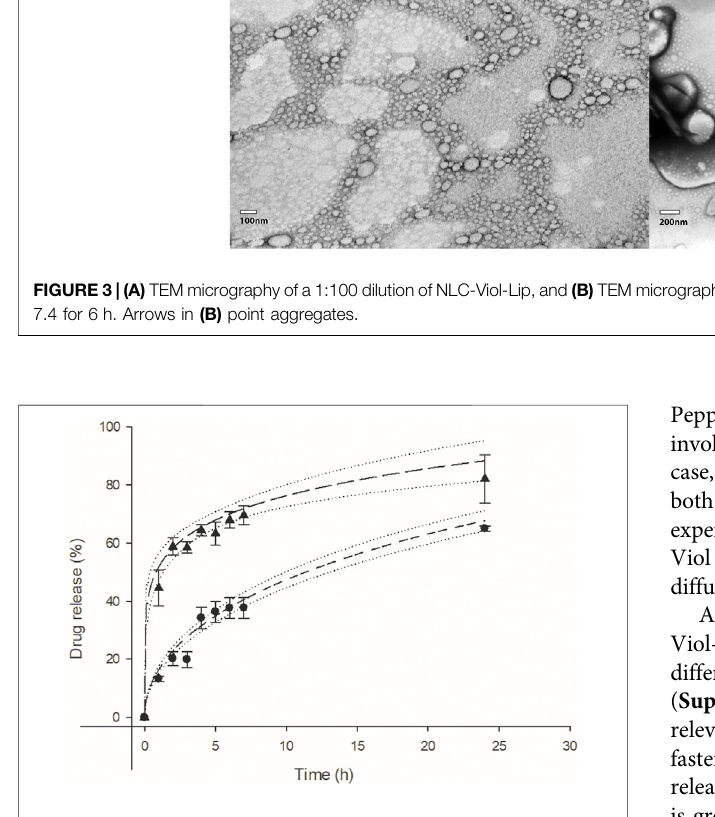
FIGURE 4 | Violacein kinetic release from mesh ( C ), and mesh containinglipase( ▲ )atpH=7.4respectively.BakerandLonsdalemodel fi tfor mesh ( − − , R 2 = 0.95) and Korsmeyer-Peppas model fi t ( −− −− , R 2 = 0.95) for mesh containing lipase. Upper and lower 95% con fi dence interval for each fi t ( ·····